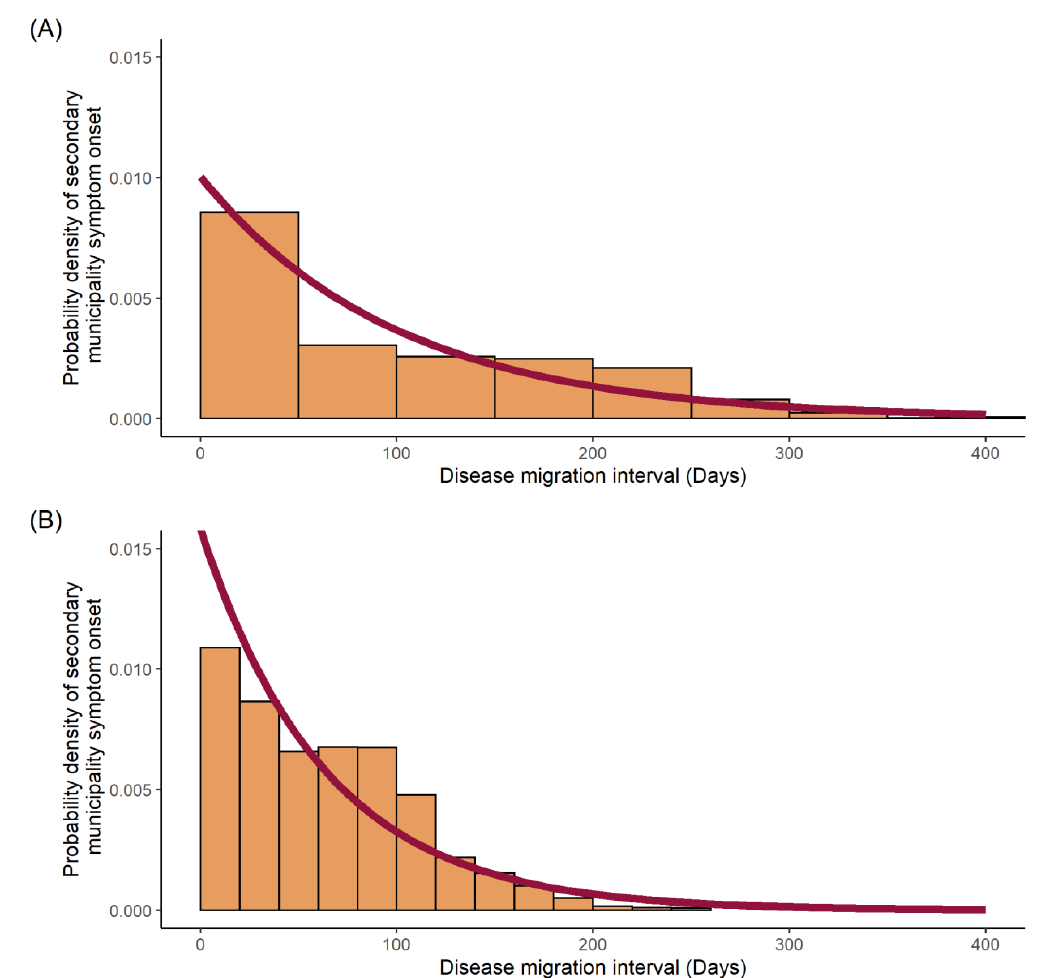
Figure 4. Disease migration interval distribution fitted to an exponential distribution: ( A ) dengue cases; ( B ) Zika cases. Probability density histograms plotted of the disease migration interval represent the distribution of time differences between initial symptom onset within each municipality. Red line represents the maximum likelihood estimation of the exponential distribution describing the